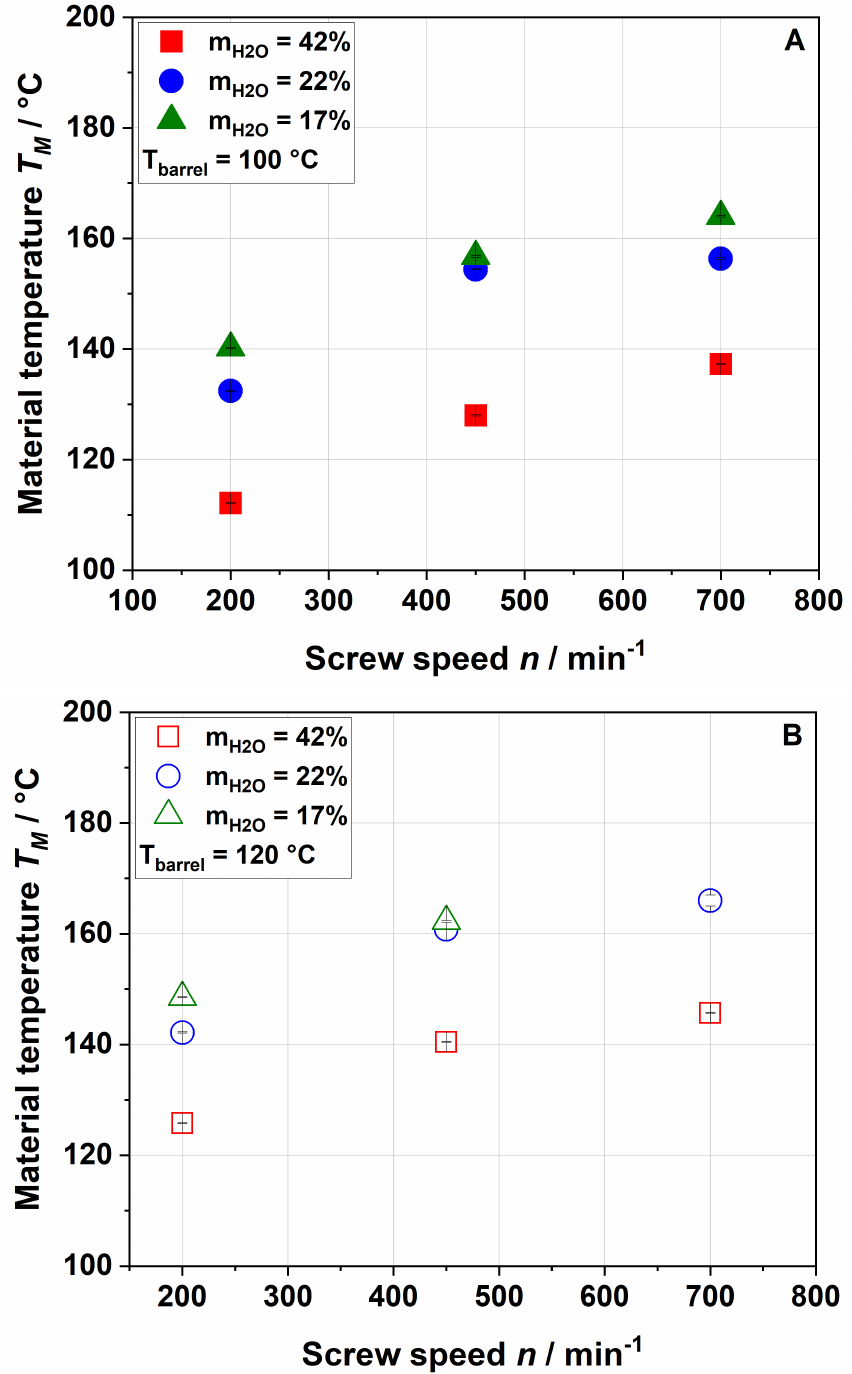
Figure 2. E ff ect of screw speed and water content on the material temperature ( T M ) measured at the die entrance at ( A ) 100 ◦ C barrel temperature and ( B ) 120 ◦ C barrel